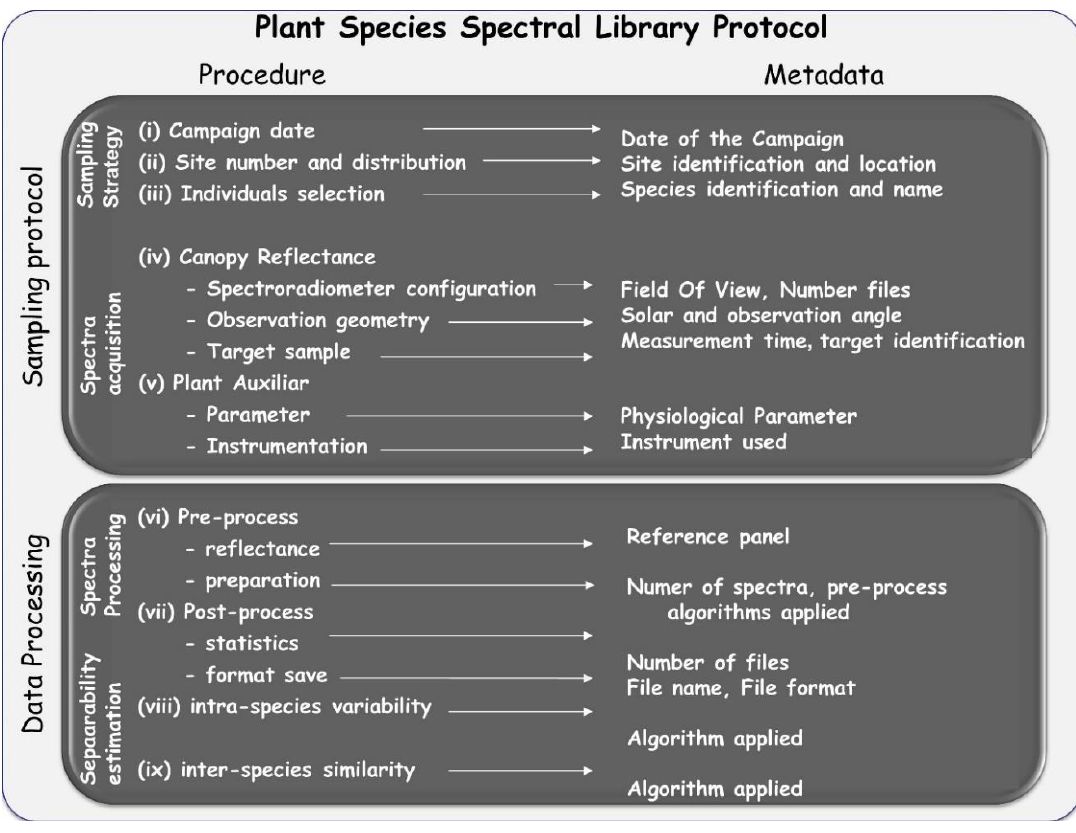
Figure 1. Field spectroscopy protocol for plant spectral library collection. The complete procedure and corresponding metadata are indicated for the sampling protocol and data